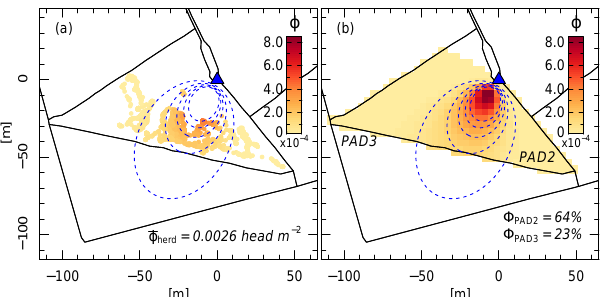
Figure 4. Determination of footprint weights for a cow herd in PAD2 during a 30min interval with two different approaches: (a) GPS method (Eq. 3) based on the actual cow positions; (b) PAD method (Eq. 5) calculating the area integrated footprint weight of the entire paddock area (here (cid:56) PAD2 = 64%) with the resolution of a 4 × 4m grid. The reddish color scale indicates the footprint weight of each location. The blue triangle indicates the position of the EC tower and the blue dashed lines are isolines of the footprint weight